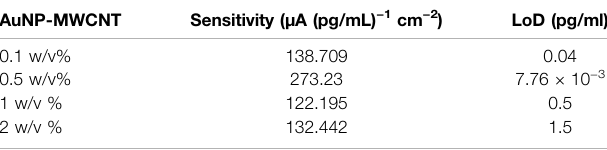
TABLE 1 | Performance comparison of the IL-10 sensor for different AuNP- MWCNT